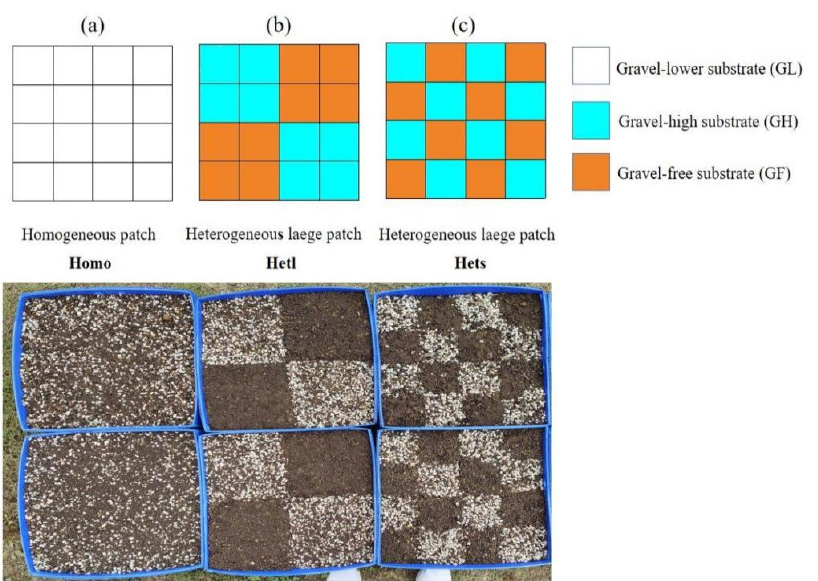
Figure 1. Schematic representation of experimental design grid patch in the square microcosm. The ( a – c ) represent homogeneous patch, heterogeneous-large patch and heterogeneous-small patch, respectively. The experiment was conducted using a square device divided into 16 patches. Homo = homogeneous patch. Hetl = heterogeneous-large patch. Hets = heterogeneous-small patch. The GL substrate was filled with a mixed substrate of 80% soil + 20% gravel, and the GF substrate was filled with a substrate of 100% soil; the GH substrate was filled with a mixed substrate of 60% soil + 40% gravel.